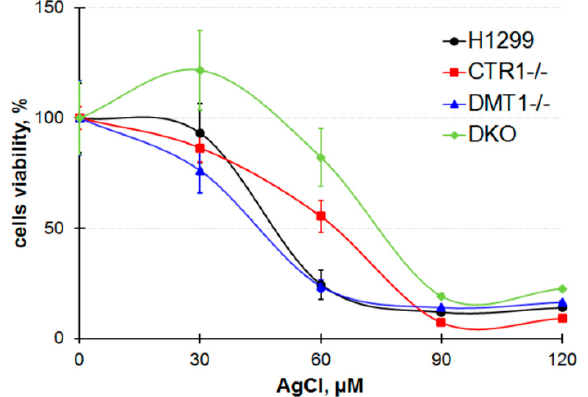
Figure 3. Cells viability after treatment in medium with AgCl for 72 h.